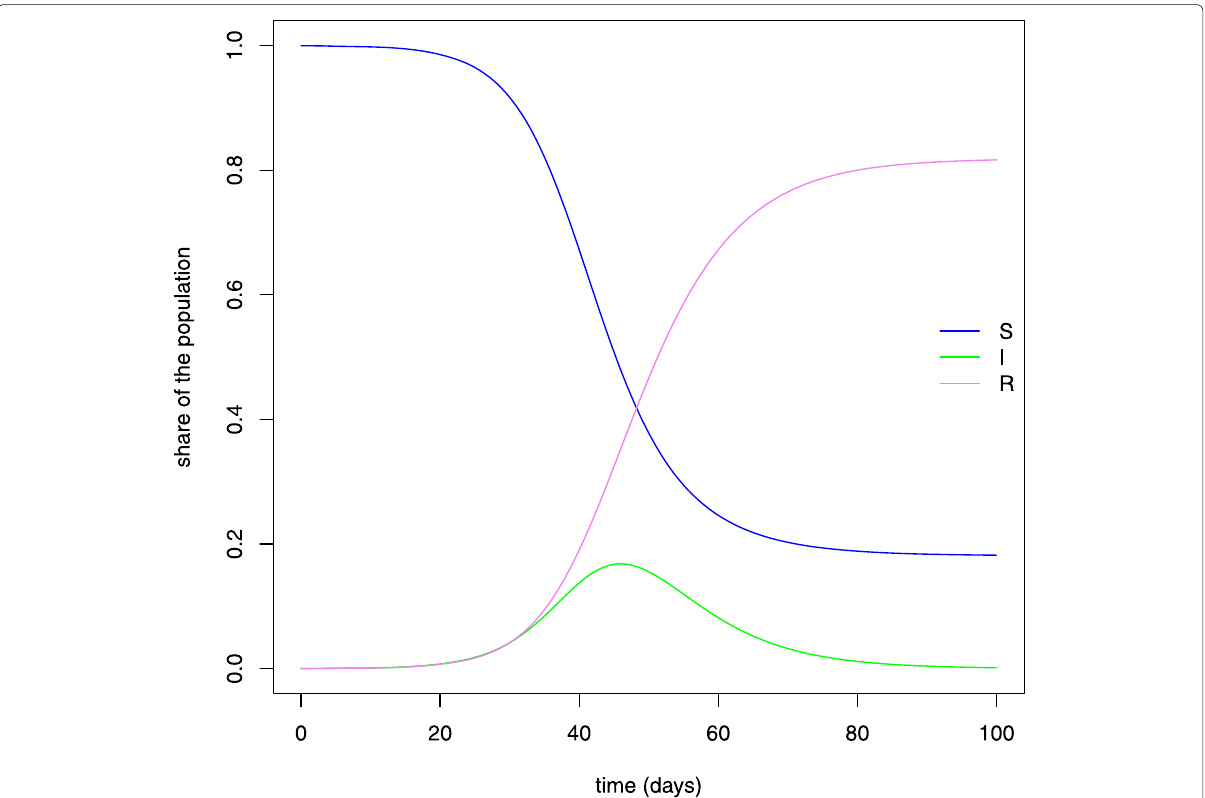
Fig. 4 SIR model. Note: This figure plots the evolution of the daily shares of individuals in each compartment according to the predictions of a basic SIR model